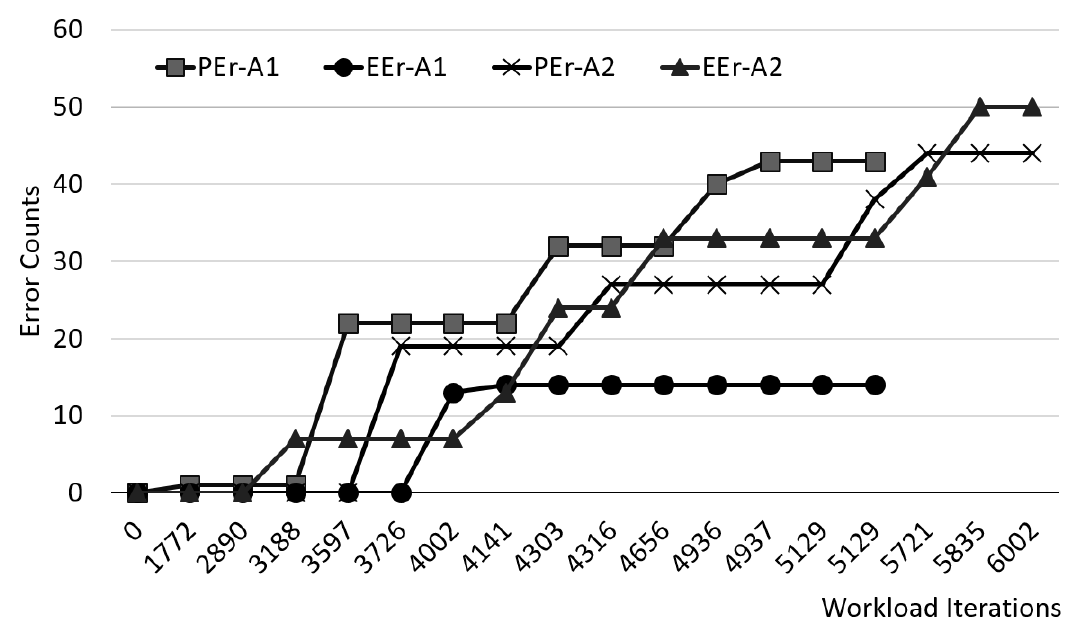
Figure 4. Trend of PEr and EEr during the whole lifetime of A1 and A2. PEr-A1 : program error count of A1; EEr-A1 : erase error count of A1; PEr-A2 : program error count of A2; EEr-A2 : erase error count of A2; X axis : pinpoint workload iteration of error occurrence; intervals are not